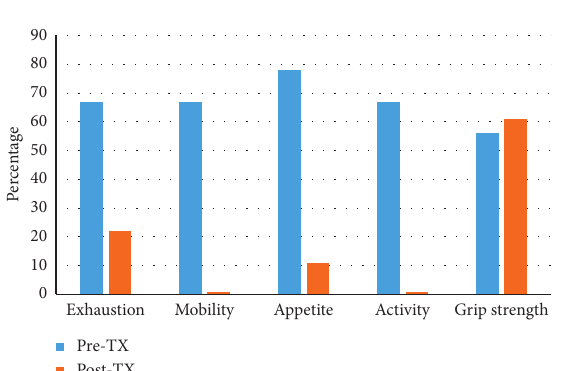
Figure 4: Changes to physical frailty domains pre-LTX vs.